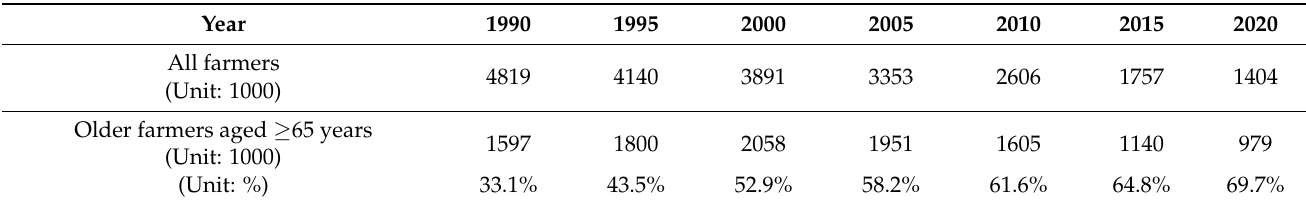
Table 1. Numbers of all farmers and older farmers aged ≥ 65